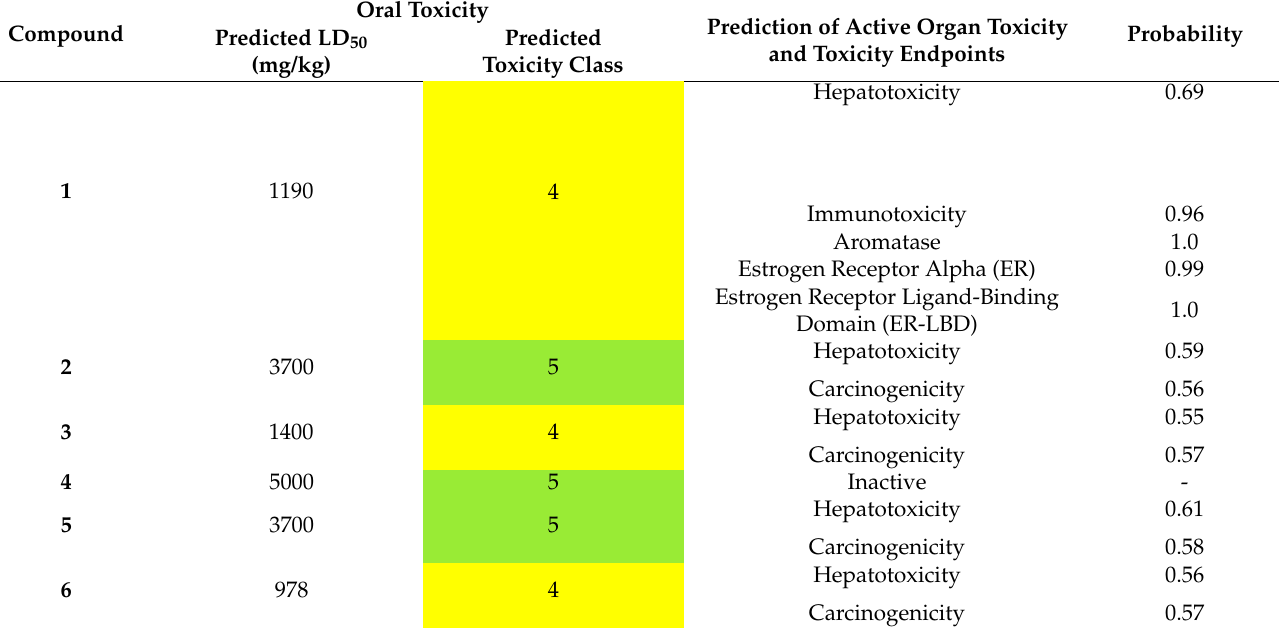
Table 7. In silico toxicity analysis of the 14 synthesized compounds using the ProTox-II webserver together with their color